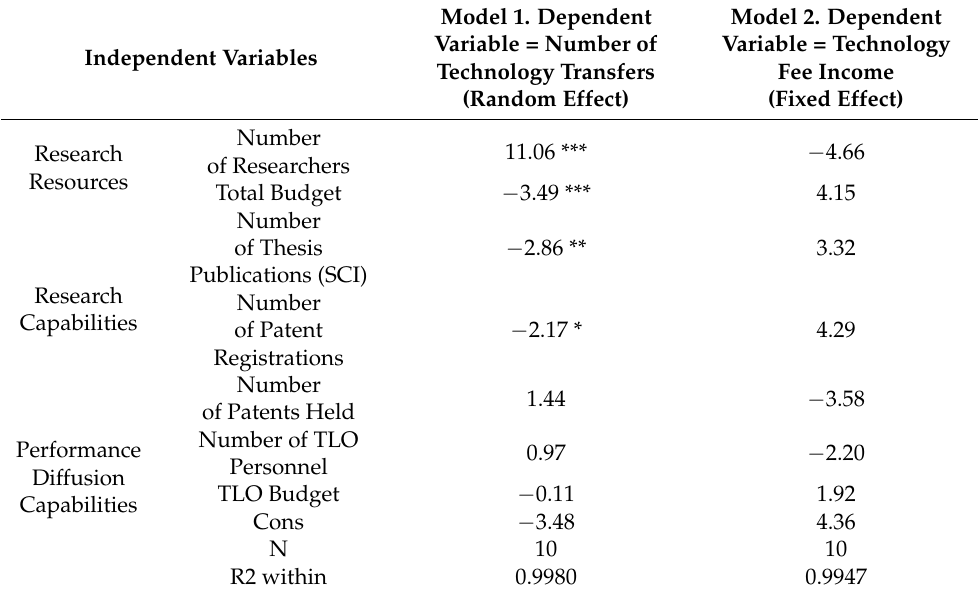
Table 6. Analysis results for basic future leading GRIs.